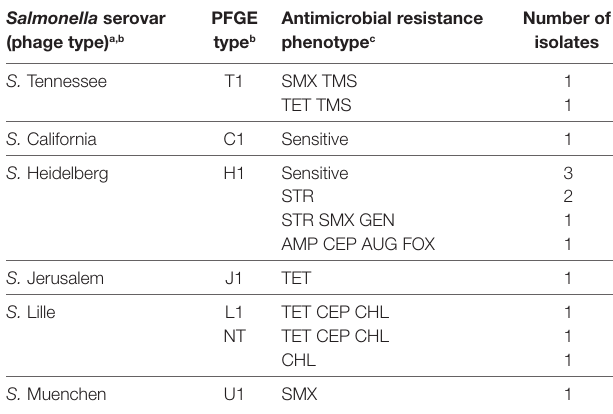
TaBle 3 | Antimicrobial resistance phenotypes of Salmonella enterica serovars and strain types isolated from commercial broiler chicken farms. Salmonella serovar (phage type)